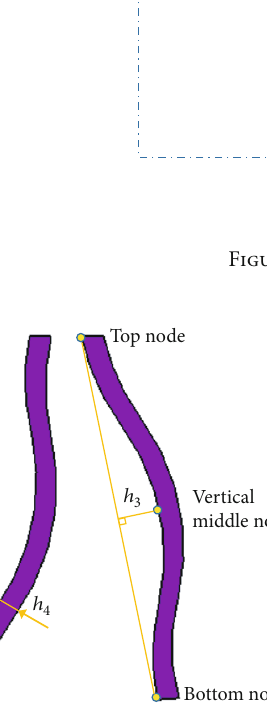
Figure 18: The de fi nition of the thickness and curvature of the spoke. Table 3: Factors and levels of OAs.